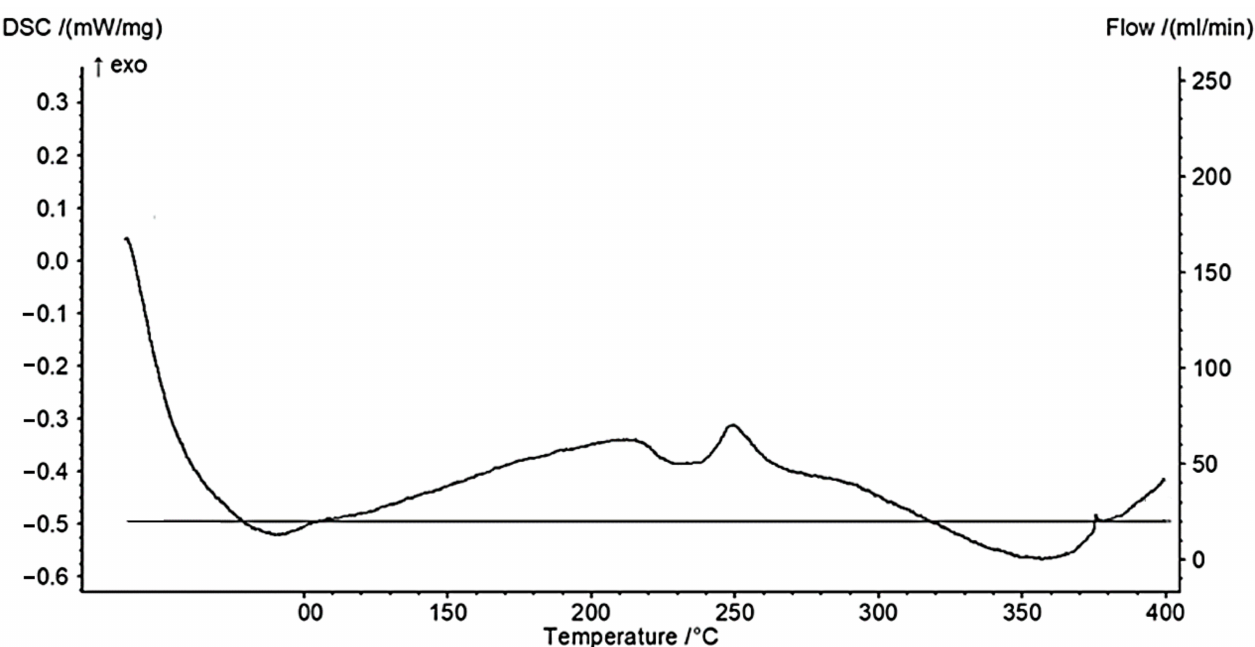
Figure 2. Differential scanning calorimetry (DSC) results based on the PPSF